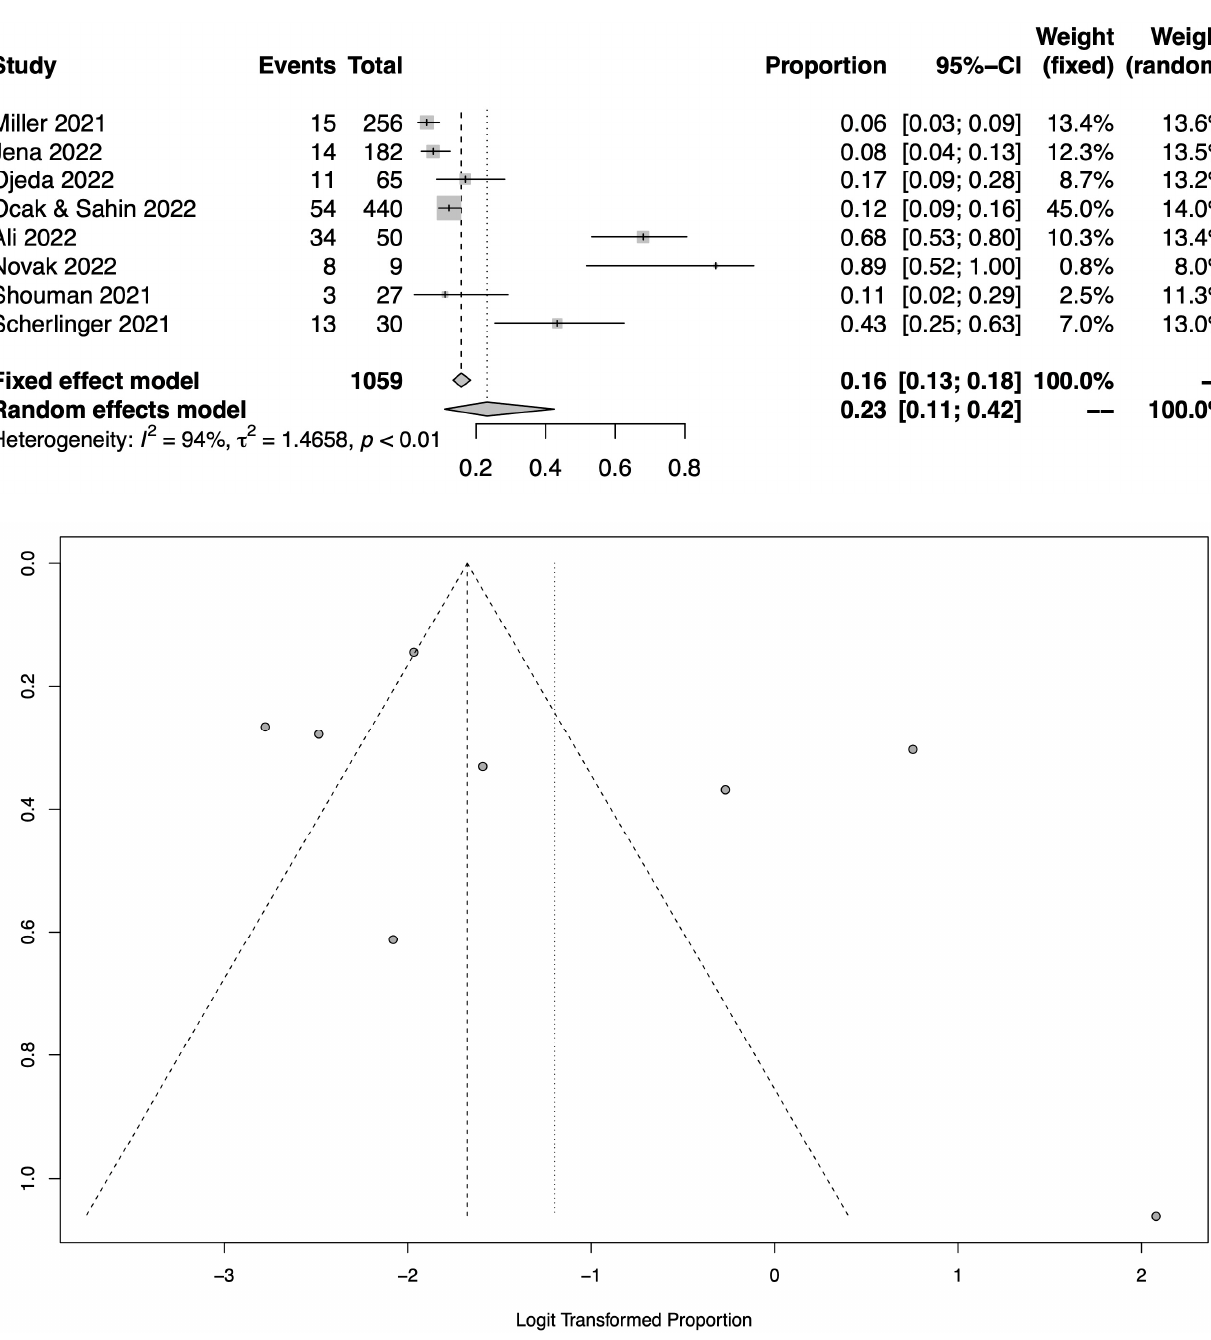
Figure 2. Meta-analysis results (all RCTs with available data) as illustrated in the forest plot and the respective funnel plot regarding the pooled prevalence estimation for COVID-19-related neuropathic pain amongst COVID-19 sufferers [23–30].